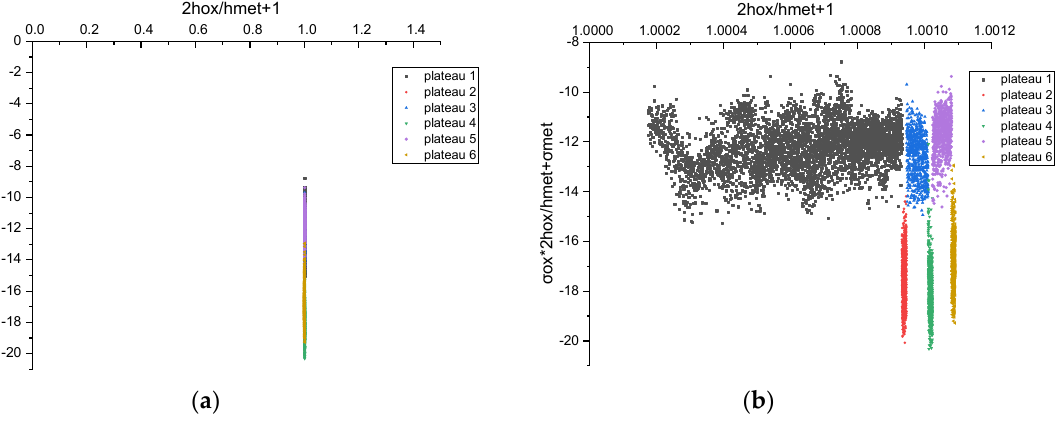
+ σ met as a function of 2 × h ox + 1 for R0.58. ( a ) shows the + σ  as a function of ×  + 1 for R0.58. ( a ) shows the h met h met